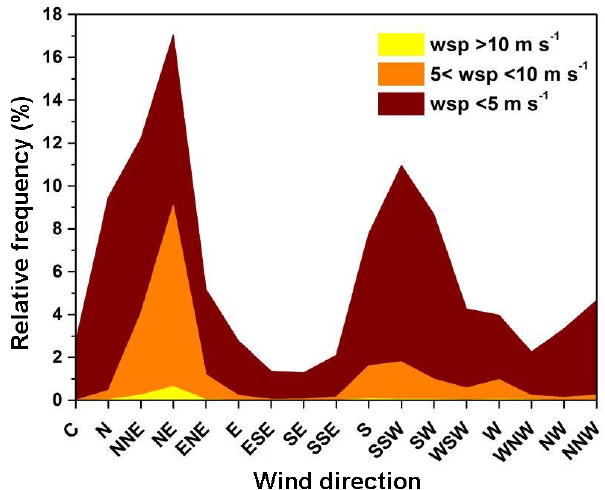
Figure 3. Relative frequencies of surface wind directions for three wind speed (wsp) categories at NOA, based on hourly val- ues of the period 1971–2000. The integral of the upper curve is 100%. For instance, the NE direction occurs cumulatively at a fre- quency of 17%, which is the sum of 7.9% (wsp < 5ms − 1 ) , 8.4% (5 < wsp < 10ms − 1 ) and 0.7% (wsp > 10ms − 1 ) . The “C” sector corresponds to calms (wsp < 0.3ms − 1 )